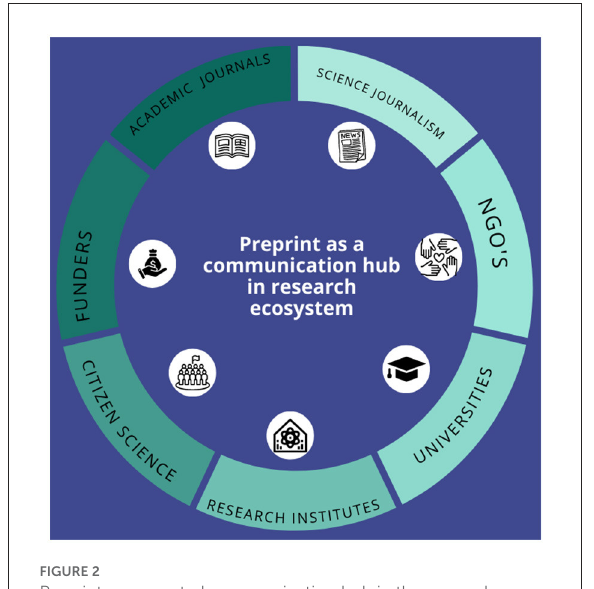
FIGURE2 Preprints as a central communication hub in the research